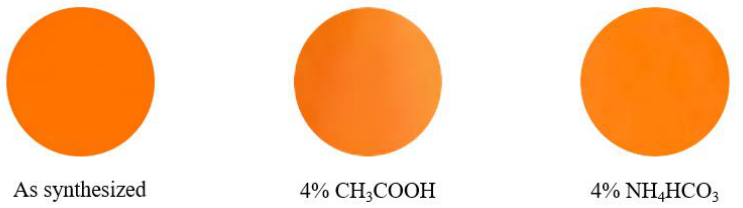
Figure 7. Photographs of the La 3 LiMn 0.97 Ti 0.03 O 7 pigment before and after the chemical stability